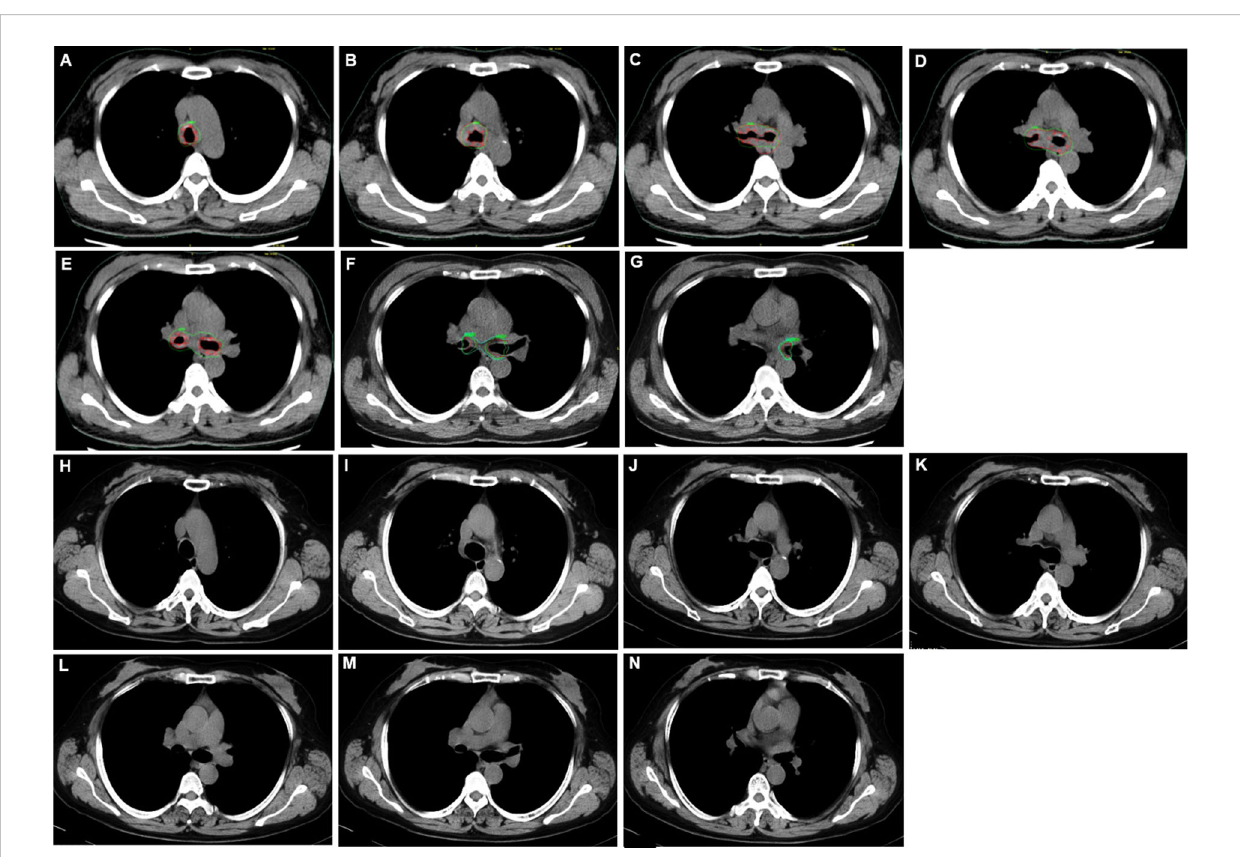
FIGURE 1 Thoracic computerized tomography (CT) scans for adenoid cystic carcinoma (ACC) in central airway. (A – G) Thoracic CT scans before placing the stent with 125 I seeds. (H – N) Thoracic CT scans 35 months after removing the stent with 125 I